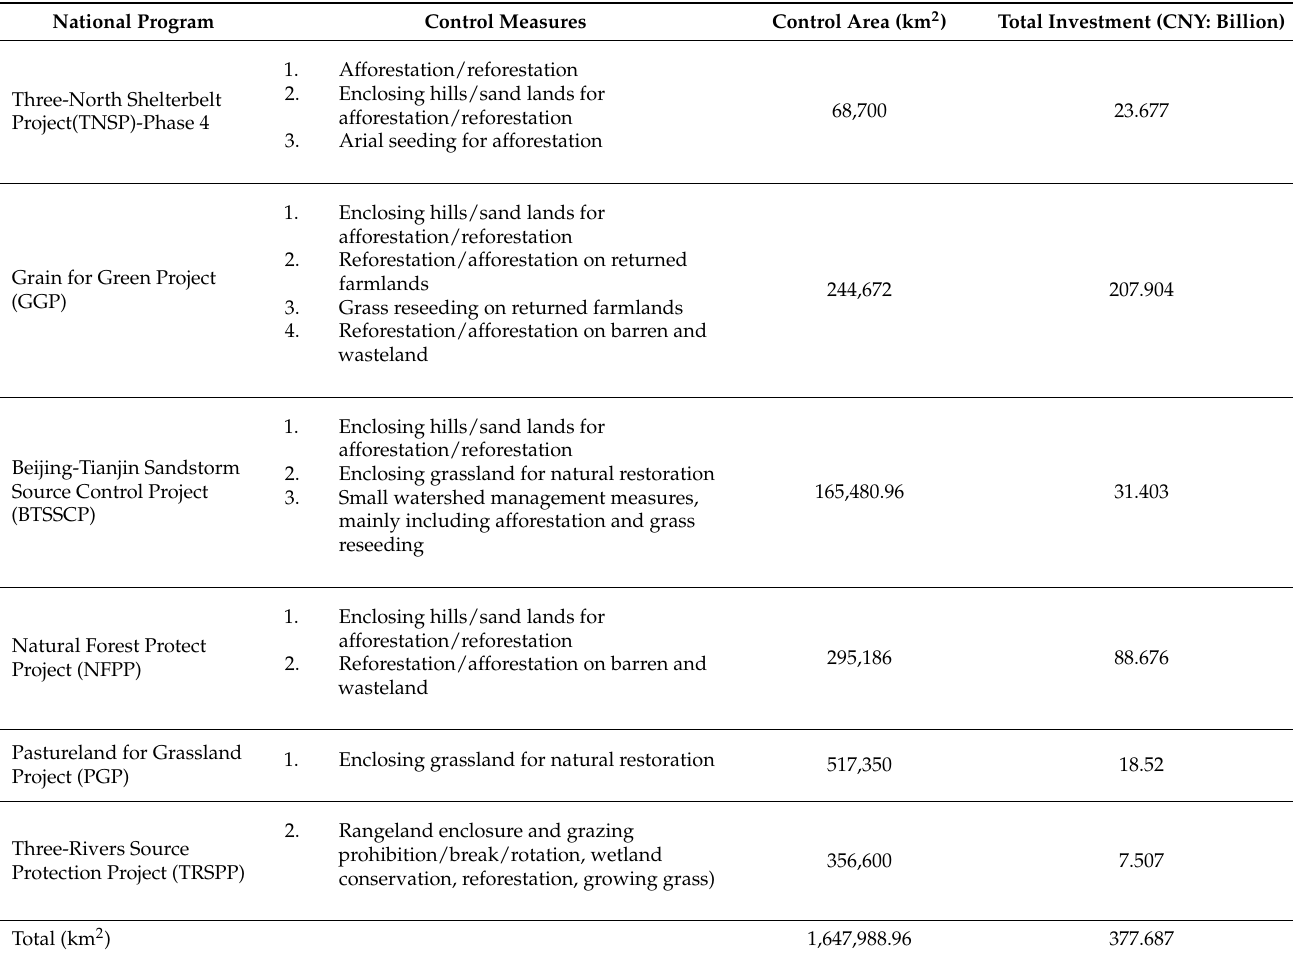
Table 1. Control area and total investment of 6 desertification combating related national programs during 2000–2010 (Adapted from IGSNRR-CAS, 2014 and confirmed at www.forestry.gov.cn) (accessed on 21 November 2020) [109]. National Program Control Measures Control Area (km 2 ) Total Investment (CNY: